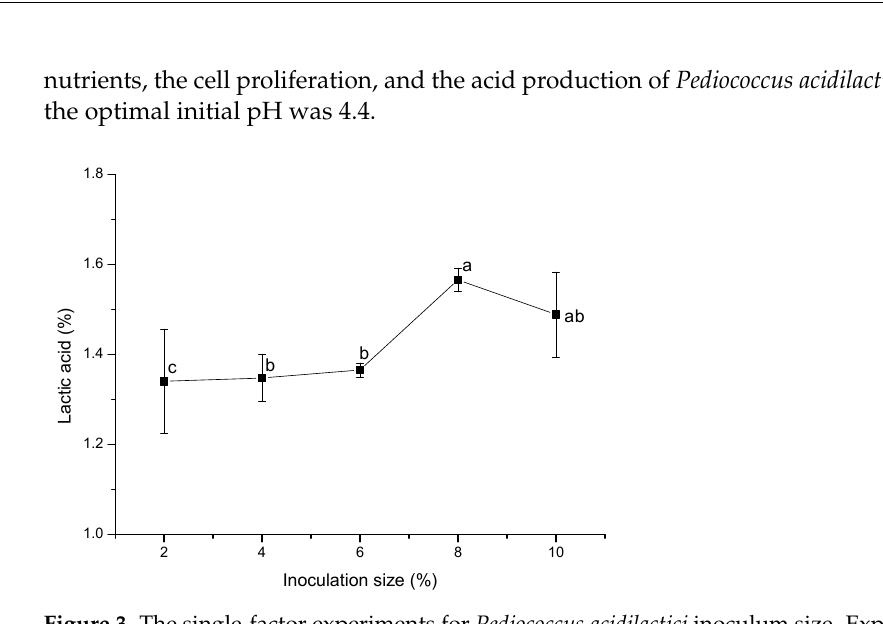
Figure 3. The single-factor experiments for Pediococcus acidilactici inoculum size. Experiments were performed in triplicate (n = 3). Sites not sharing a common letter showed significant differences ( p < 0.05).